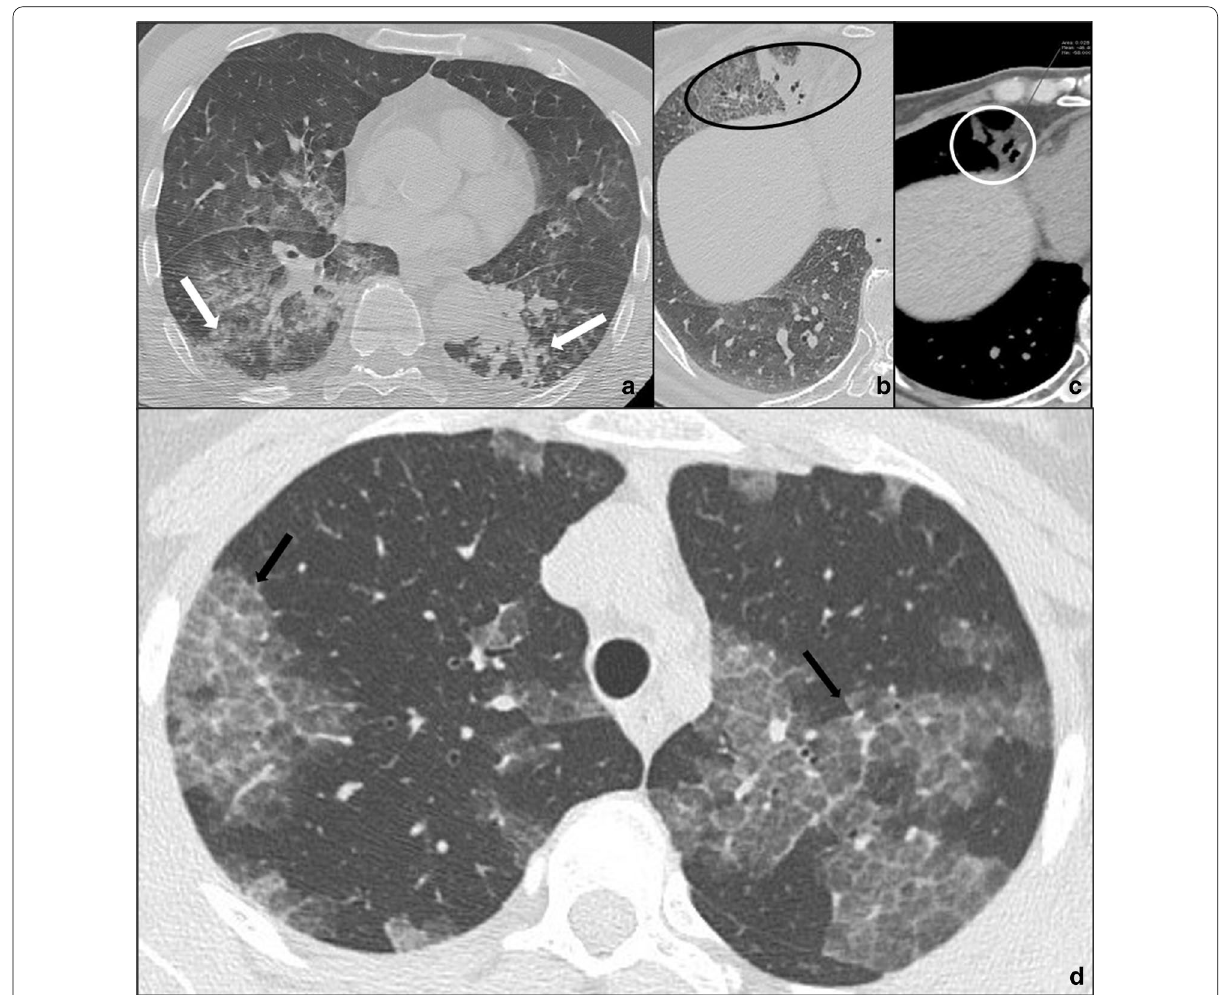
Fig. 5 a – d COVID-19 pneumonia differential diagnoses: aspiration pneumonia, pulmonary alveolar proteinosis. HRTCs of two patients affected by fluid aspiration pneumonia presenting with bilateral, dependent and confluent consolidative foci (white arrows in a ) and chronic lipoid pneumonia ( b , c ), showing a low density consolidation (mean:- 46UH in white circle in c ) surrounded by a crazy paving halo (black oval b ). Pulmonary alveolar proteinosis is characterised by bilateral areas of crazy paving (black arrows in d ) and a peculiar juxtaposition of severely affected secondary lobules and normal secondary